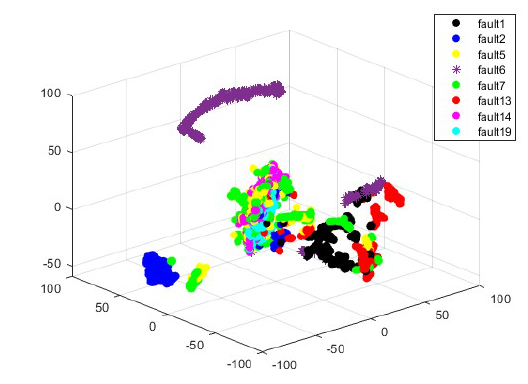
Figure 8. The t–SNE visualization results of Original